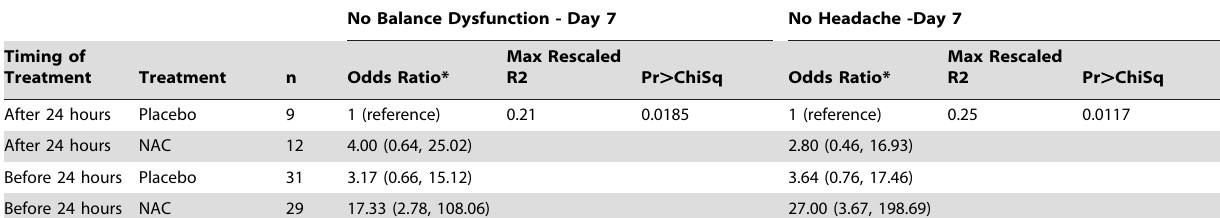
Table 5. Treatment Effects: Day 7 Symptoms.